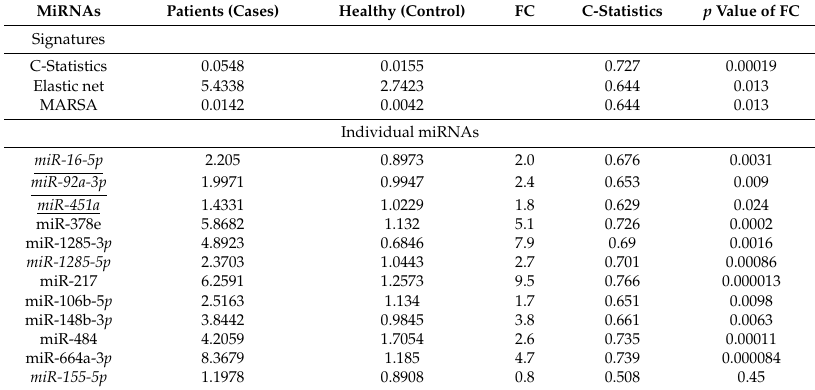
Table 3. Validation results for the signatures and individual miRNAs (median expression levels) in a separate cohort of lung cancer patients (cases) and healthy